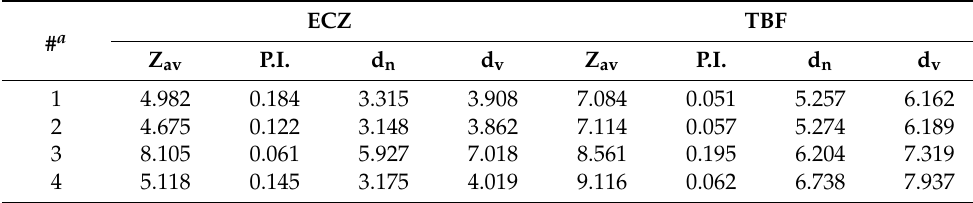
Table 2. Size characterization of ECZ- and TBF-loaded micelles.